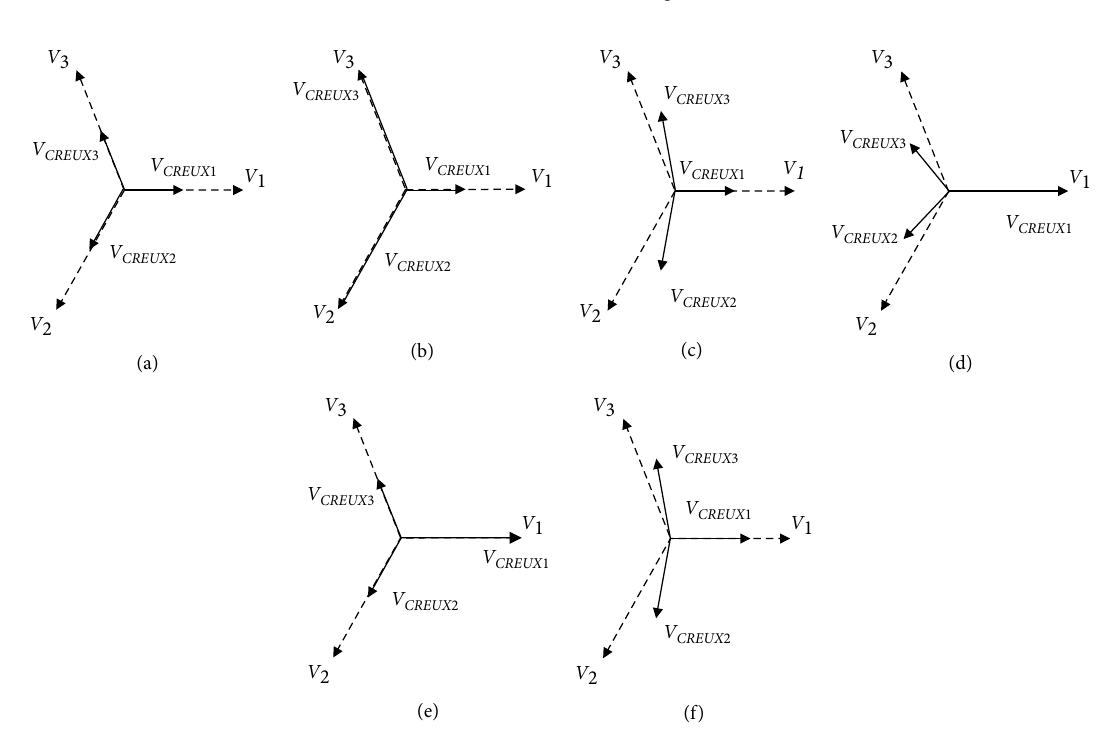
Figure 10: Classification of voltage dips